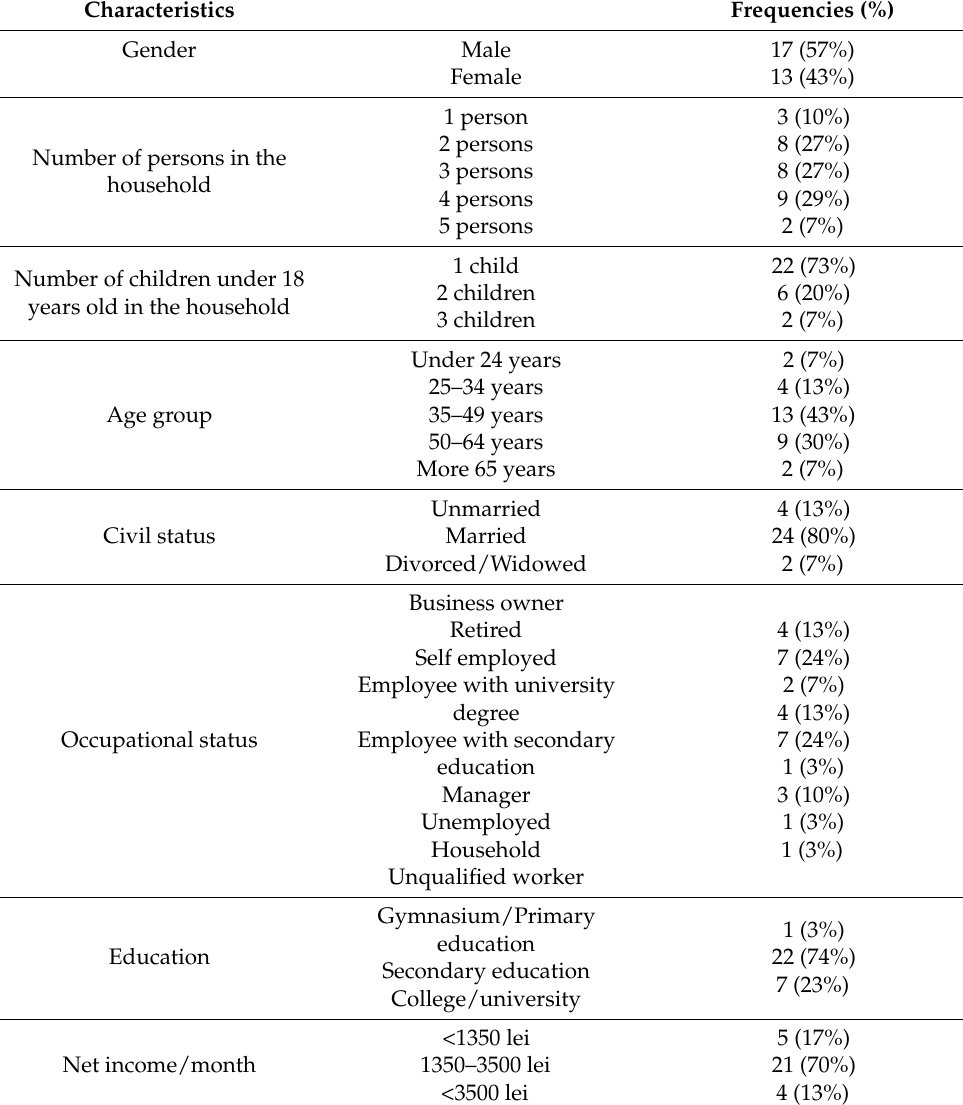
Table 1. The structure of the